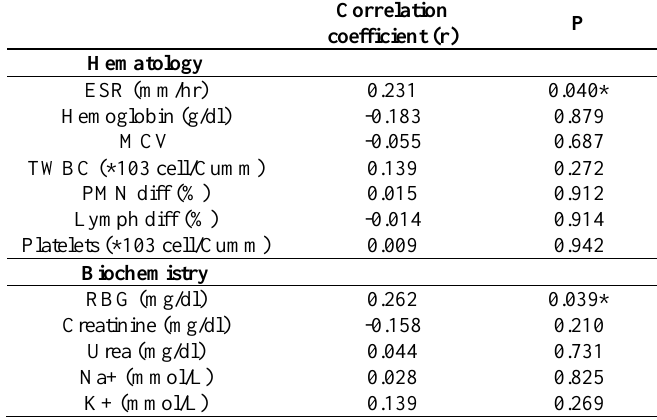
Table 4 : The Pearson’s correlation between CRP levels and laboratory